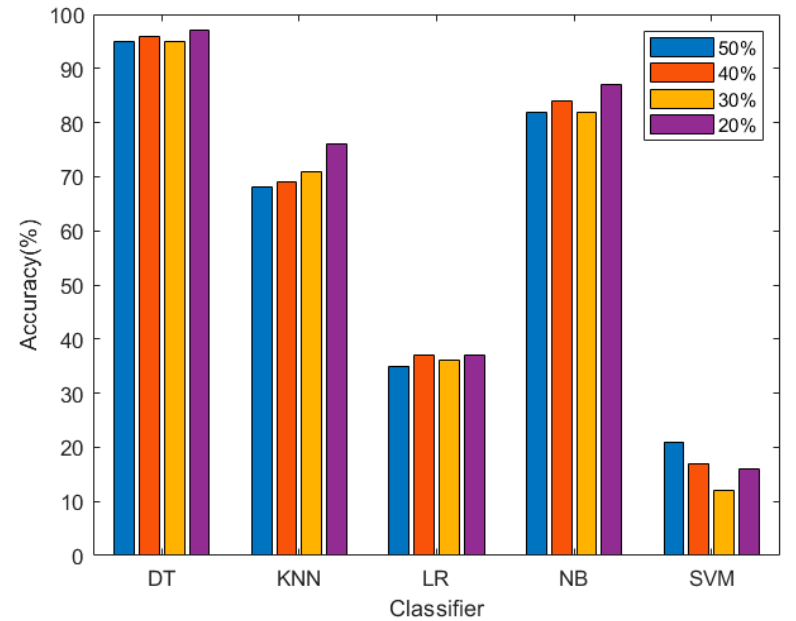
Figure 10. Accuracy distribution group by technique.